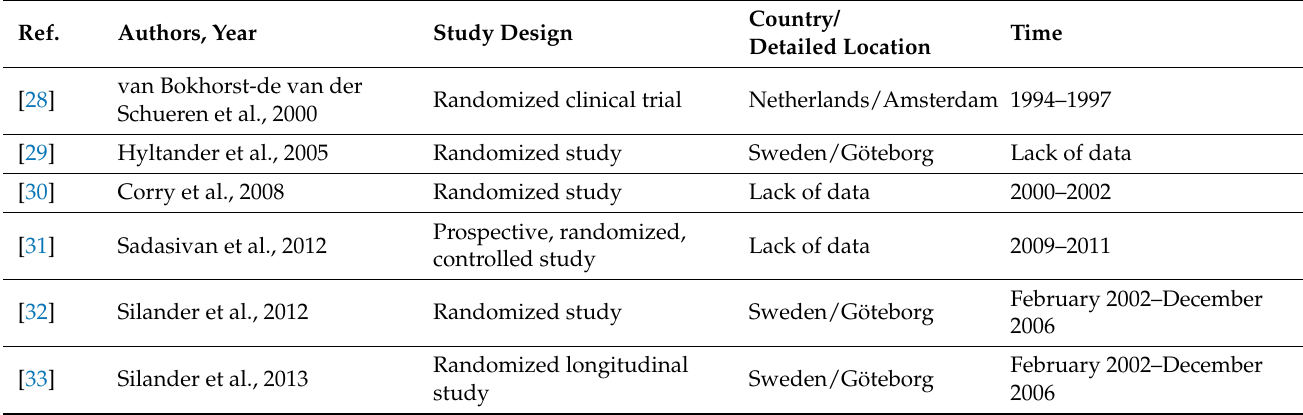
Table 3. The basic characteristics of the studies included in the systematic review.